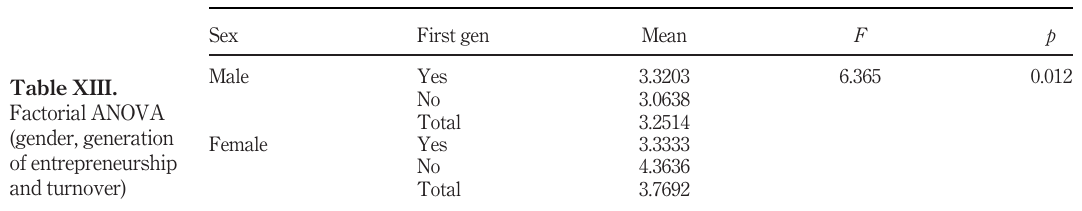
Table XII. Factorial ANOVA (gender, organization age and turnover)